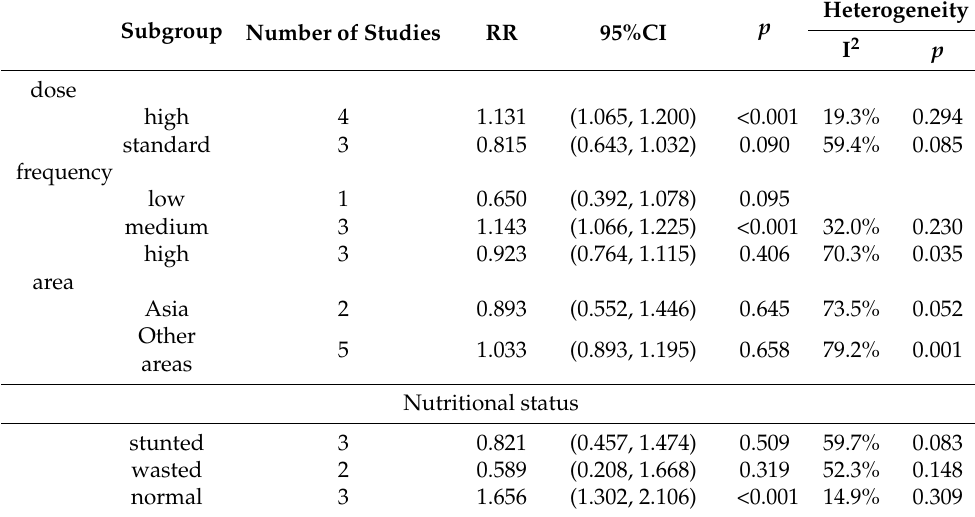
Table 3. Subgroup analyses—incidence of acute respiratory tract infection.